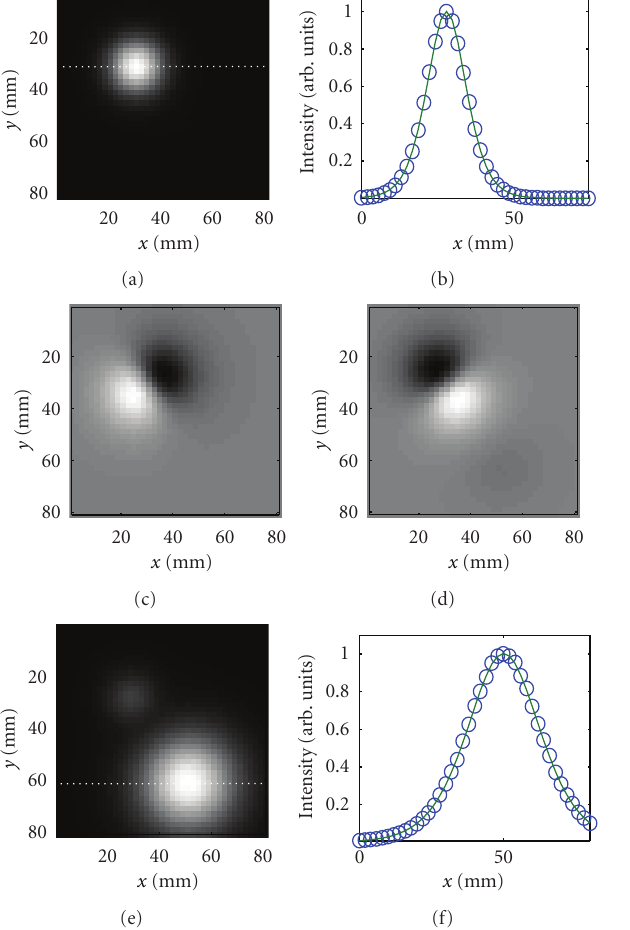
Figure 4: PCA-extracted two-dimensional intensity distribution on the detector plane of: (a) the centrosymmetric component; and (c) and (d) dumb-bell shaped components of the scattering target; (e) the absorptive target. Green’s function fits to the spatial intensity profiles along the dashed line (shown in figures) of the (b) centrosymmetric component of the scattering target and (f) absorptive target, respectively, to retrieve the locations of the two targets.